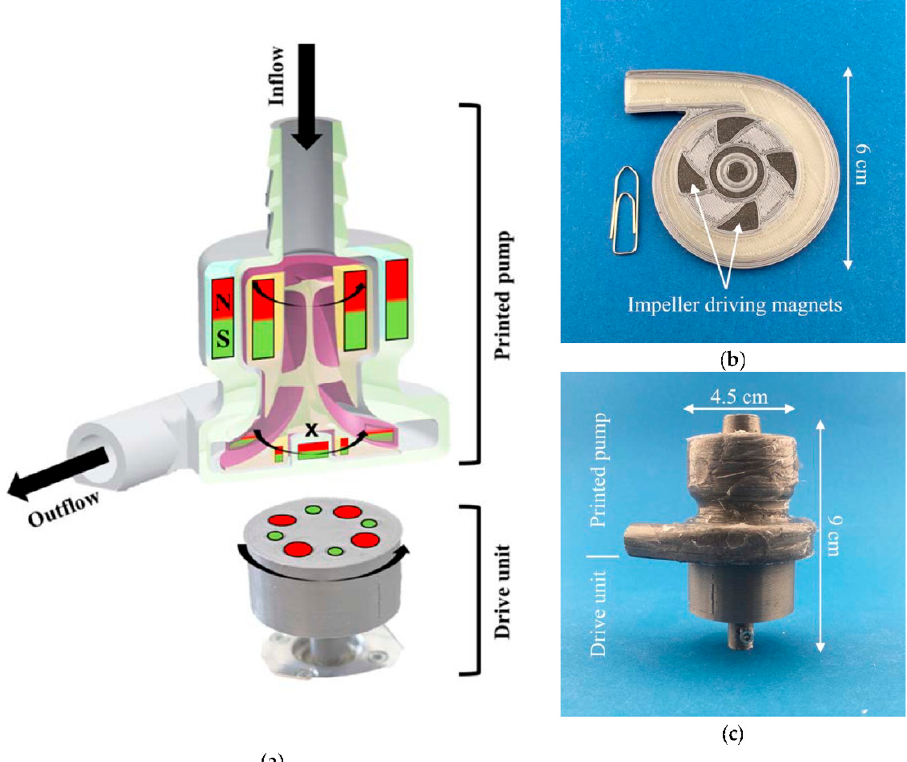
Figure 1. ( a ) Design scheme and coupling of the printed pump with integrated driving and bearing magnets in the housing and impeller; ( b ) Cross-section of the printed pump showing the used materials in different colors (silver: PLA, black: magnetic compound, beige: water-soluble BVOH); ( c ) Fully printed pump with drive unit after removal of support material (no magnets visible, coated with silicone).